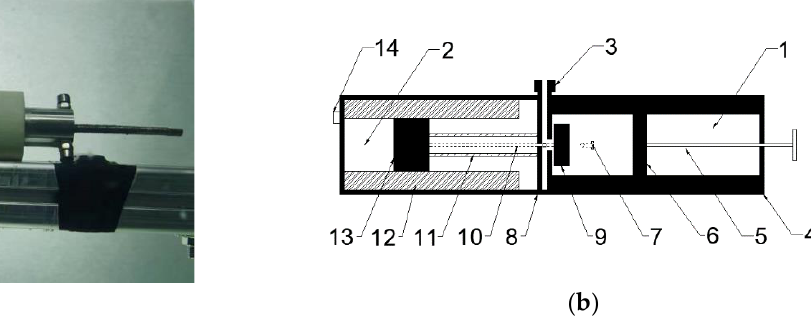
Figure 1. Equipment of the airgun: (1) air storage chamber, (2) solenoid valve, (3) exhaust port, (4) cylinder body, (5) capacity control rod, (6) piston seal, (7) intake port, (8) solenoid valve outer shell, (9) sealing element, (10) movable bar, (11) reset spring, (12) electromagnetic coil, (13) cast iron, (14) wire interface. ( a ) real objects, ( b ) schematic view.